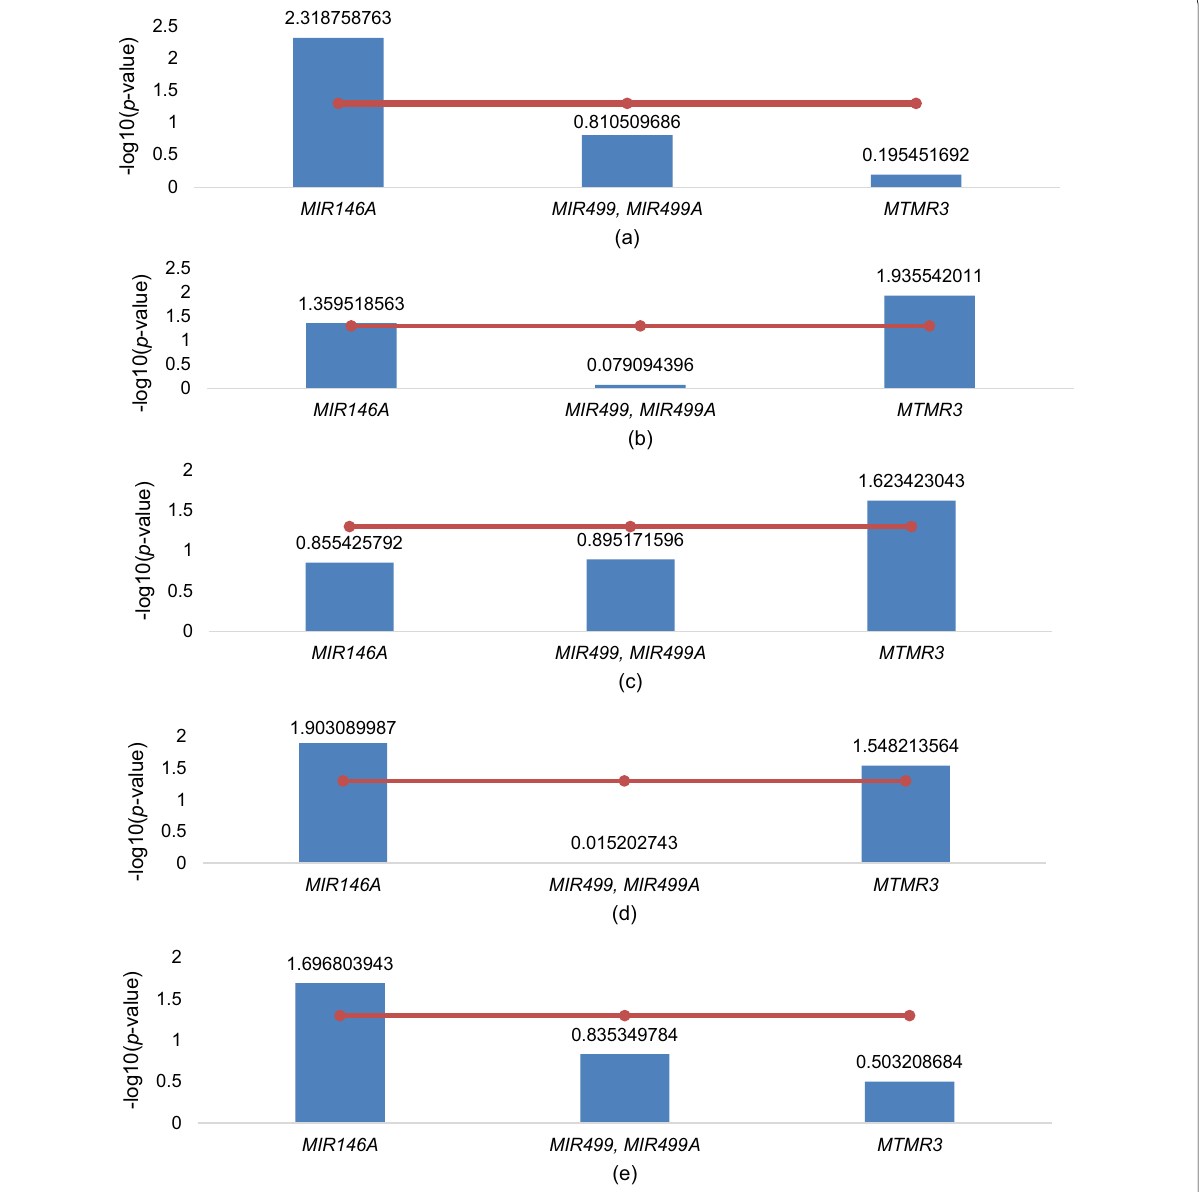
Fig. 1 Association analysis for examined SNPs with RA disease. The horizontal line in each model represents the significance level of the p value (0.05). a Multiplicative model, b dominant model, c recessive model, d co-dominant with heterozygote model, e co-dominant with minor homozygote